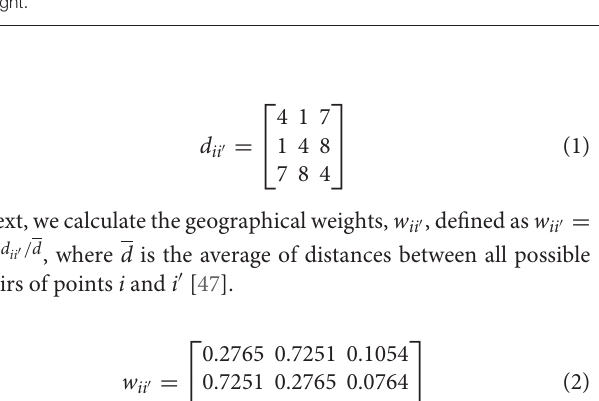
FIGURE 5 | The mean HbO activity for Grouping 2 by stage for each participant. The vertical line at day 13 for participant 1 indicates set 1 to the left and set 2 to the